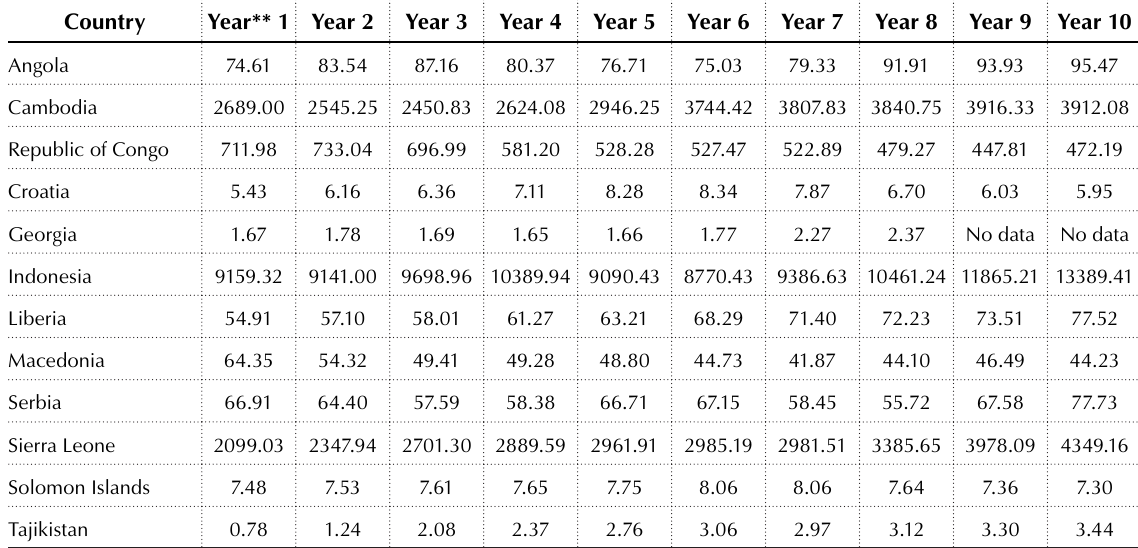
Source: World bank Open